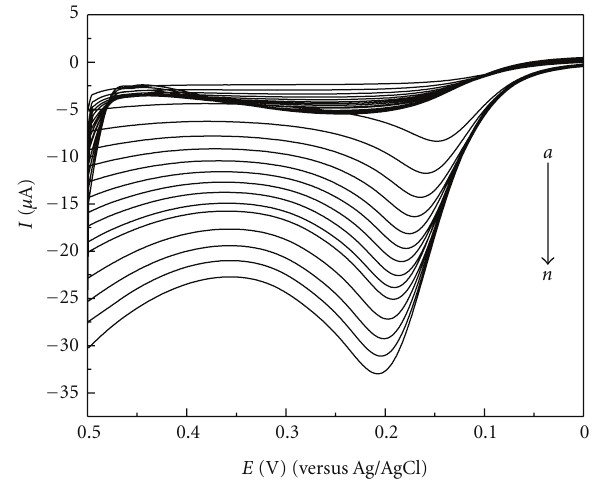
Figure 4: Cyclic voltammetric curves of nano-CuO/GCE in 0.01 M NaOH + 0.09 M KCl solution containing 0.1 mM H 2 O 2 at di ff erent scan rates. Scan rates: ( a ) −→ ( n ) 0.01, 0.02, 0.03, 0.04, 0.05, 0.06, 0.07, 0.08, 0.09, 0.10, 0.12, 0.14, 0.16, and 0.18, Vs − 1 ,